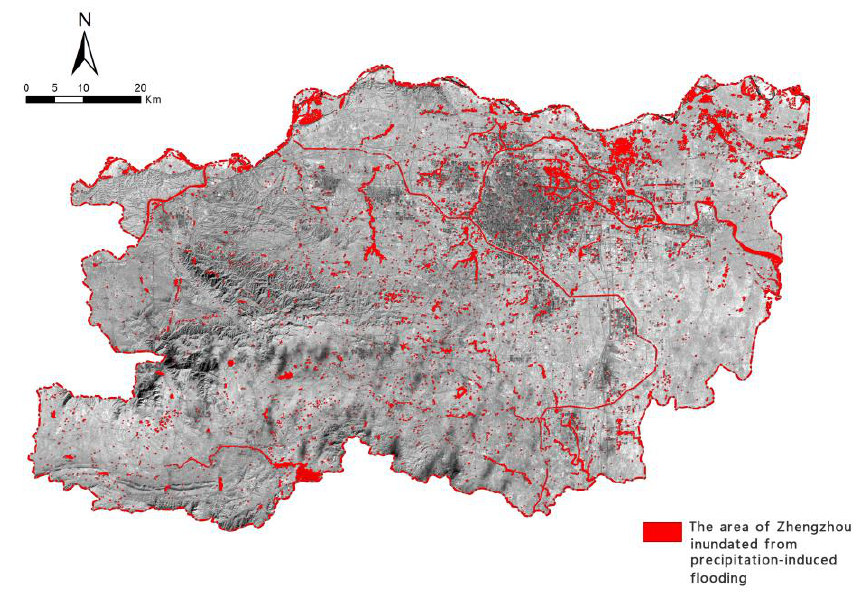
Figure 2. The area of Zhengzhou inundated from precipitation-induced flooding.